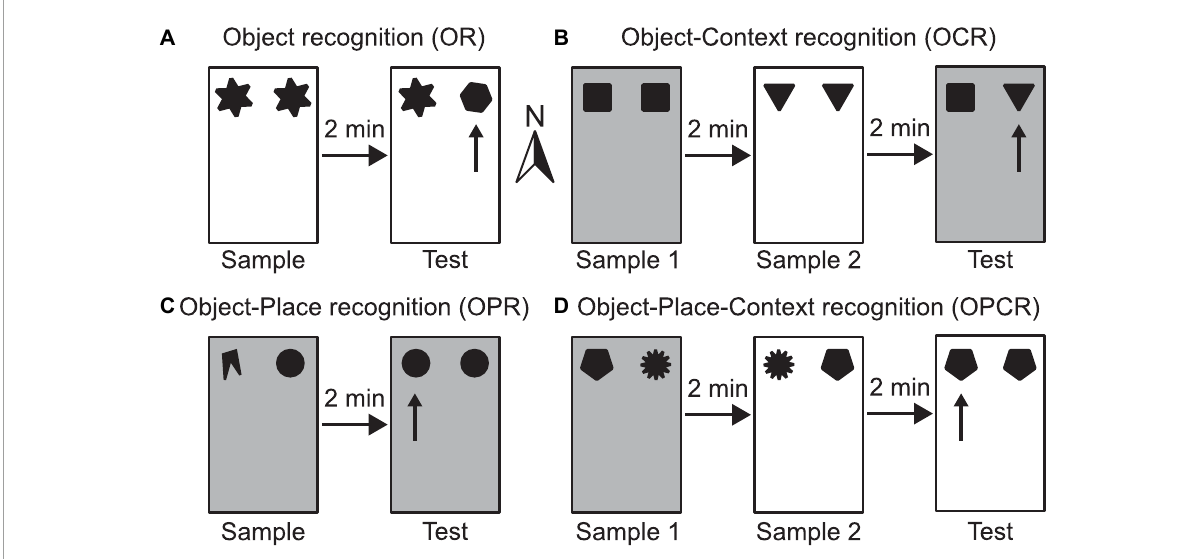
FIGURE1 Schematic illustrations of example configurations for the four spontaneous object exploration tasks used (A–D) . Rectangles depict the testing box, which can be configured either as context 1 (shown as white) or context 2 (shown as grey) by changing floor and wall inserts. The different shapes represent different objects used. (A) OR task–the arrow indicates which object is novel in the test phase; (B) OCR task–the arrow indicates which objects in a novel configuration with respect to its context in the test phase; (C) OPR task–the arrow indicates which object is in a novel configuration with respect to its position in the test phase; (D) OPCR task–the arrow indicates which object is in a novel configuration with respect to the combination of position and context in the test phase. Compass arrow indicates conventional north referenced in methods’